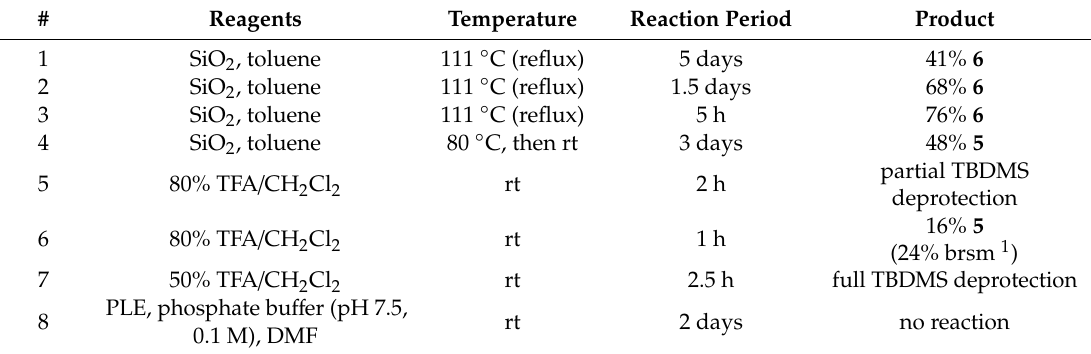
Table 1. Investigated conditions for the attempted reaction of 4 to 5 (see Scheme 2).